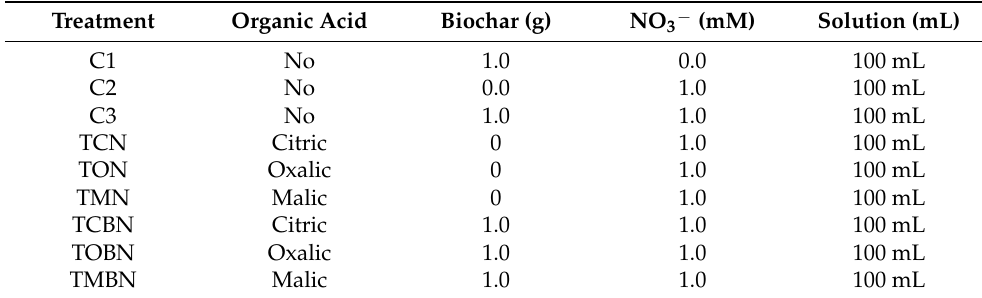
Table 5. Details on water solution experimental